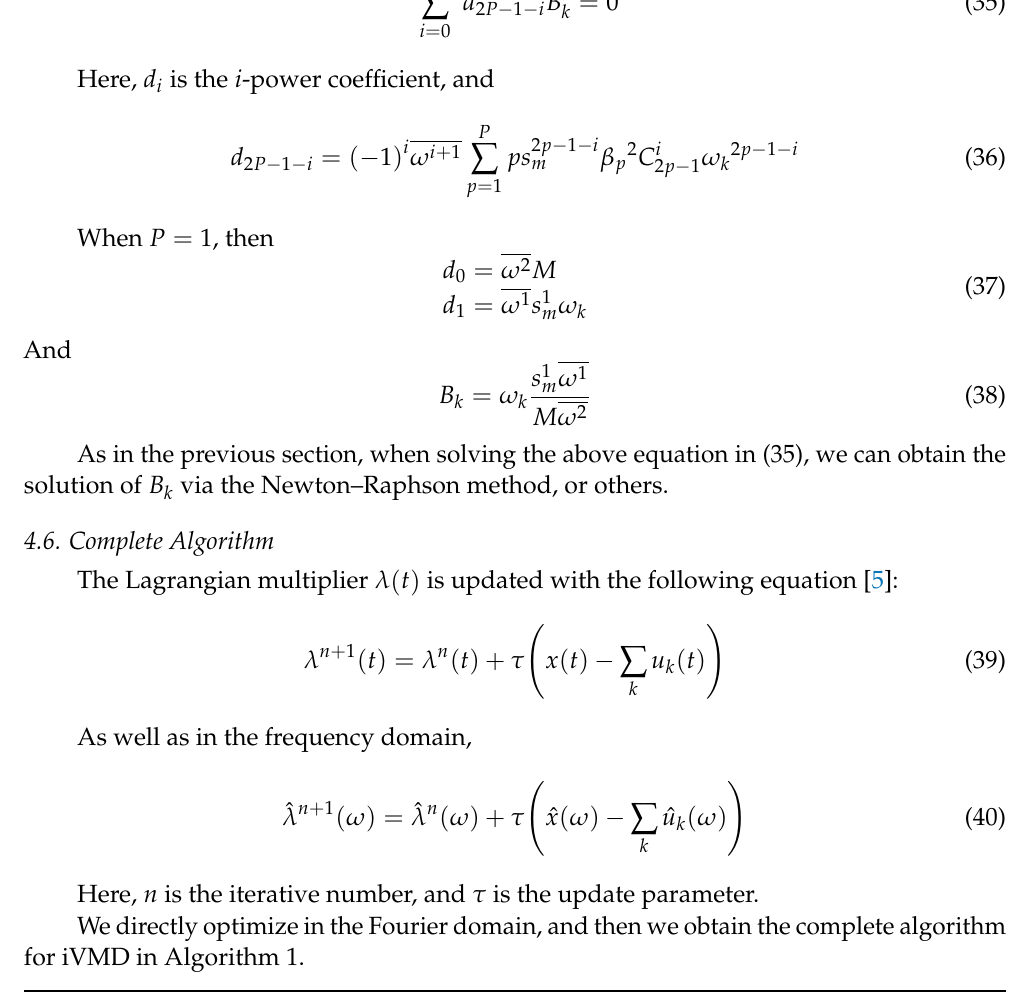
Algorithm 1: Complete optimization of